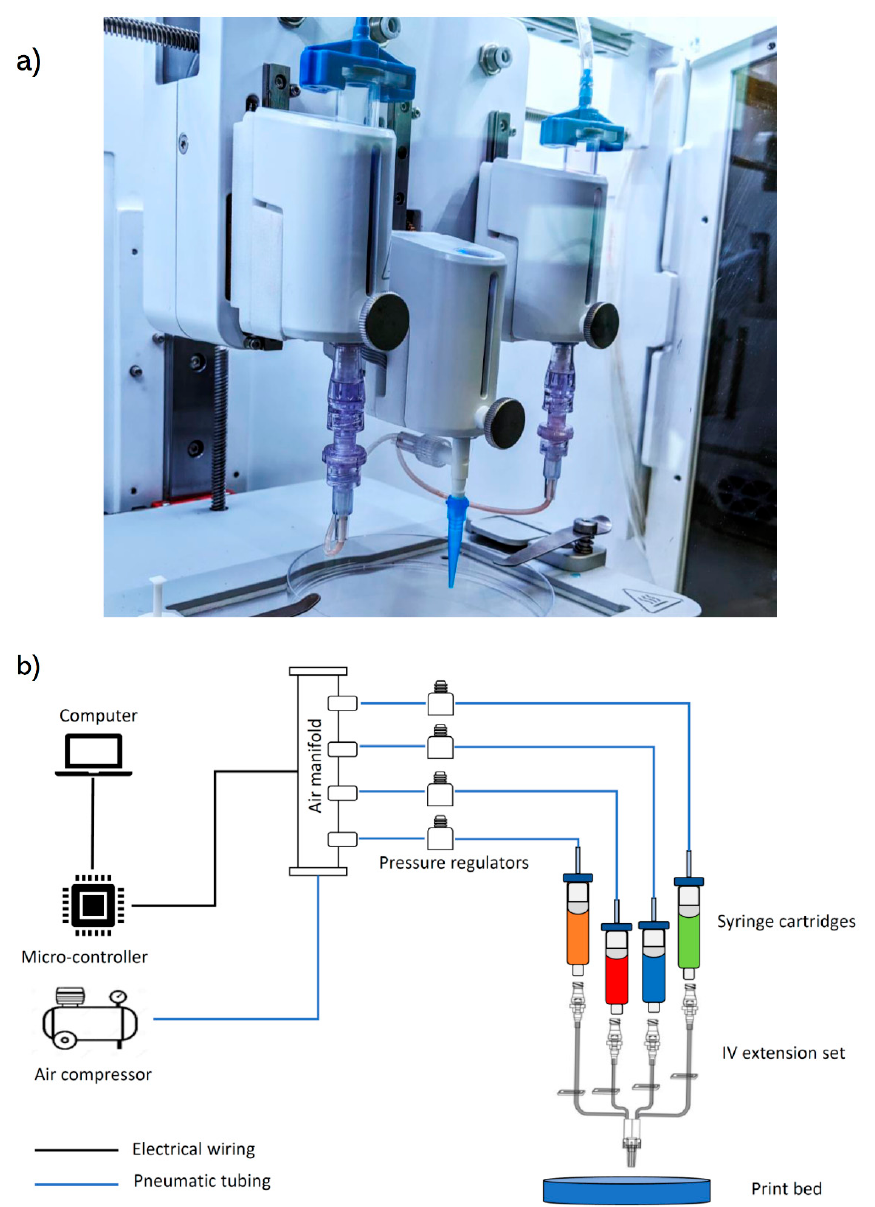
Figure 1. ( a ) Assembly of the SNMM printhead on a commercial BioX 3D bioprinter, ( b )